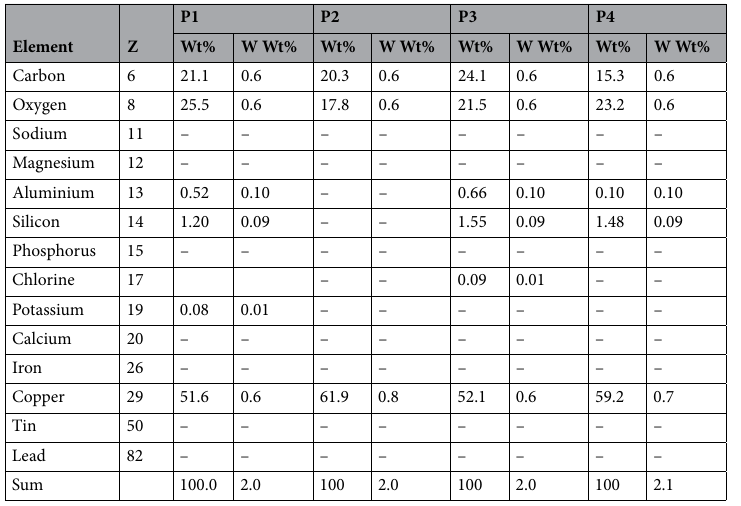
Table 1. Elemental composition of the sampling points of inclusion #1 mapped in Fig. 4a. Data collected with FESEM-EDS.